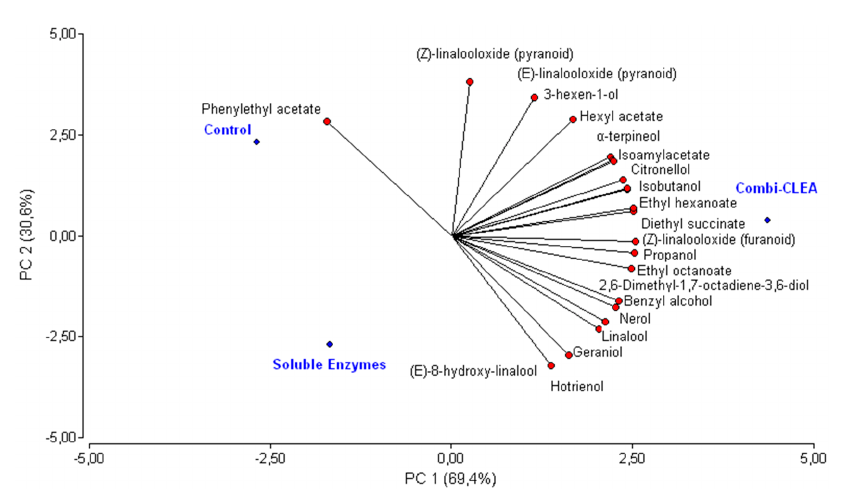
Figure 2. Principal components analysis (PCA) performed with volatile composition (µg/L) in Muscat wines from untreated, control, and treated wines with soluble enzymes and combi-CLEAs. wines from untreated, control, and treated wines with soluble enzymes and